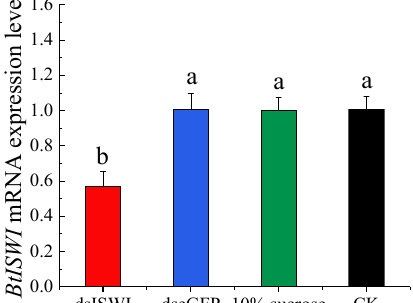
Figure 6. E ff ect of double-stranded RNA (dsRNA) treatment on Bemisia tabaci MEAM1 BtISWI mRNA expression level. BtISWI mRNA expression in whiteflies fed BtISWI dsRNA (dsISWI) for 3 h was significantly decreased compared to the controls: whiteflies untreated or fed eGFP dsRNA (dseGFP) or 10% sucrose. The expression levels are expressed as the mean ± SEM. Bars with di ff erent lowercase letters are significantly di ff erent at p < 0.05.